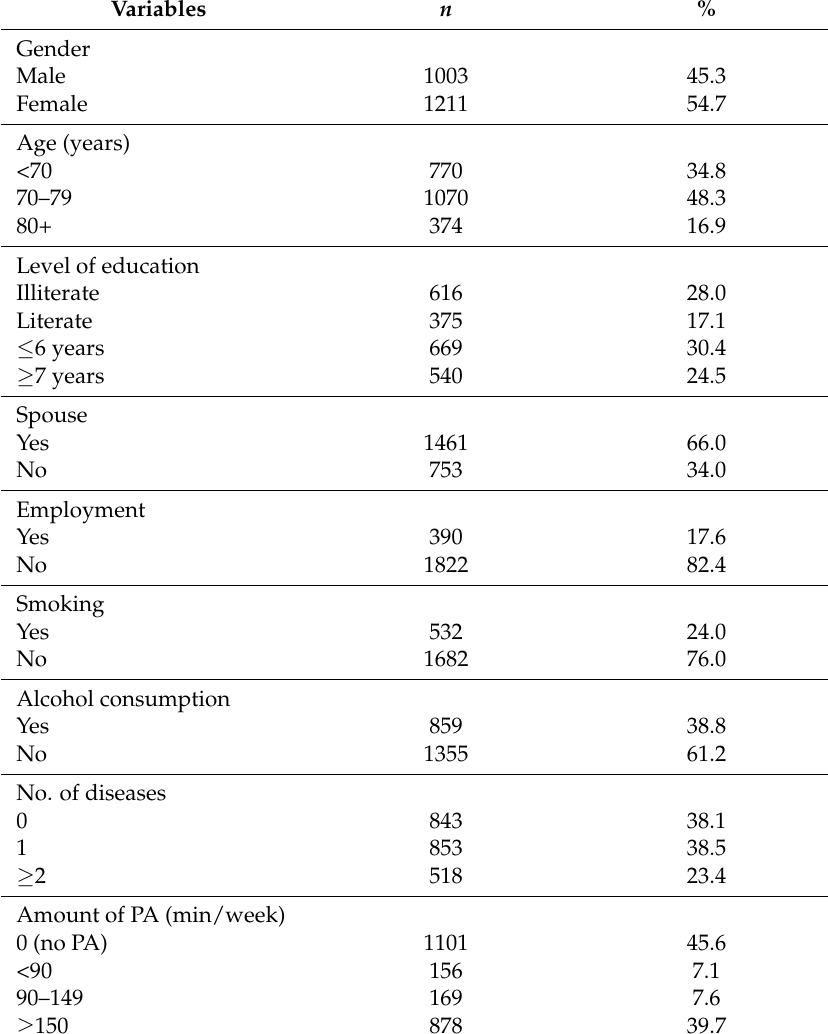
Table 1. Characteristics of participants ( n =